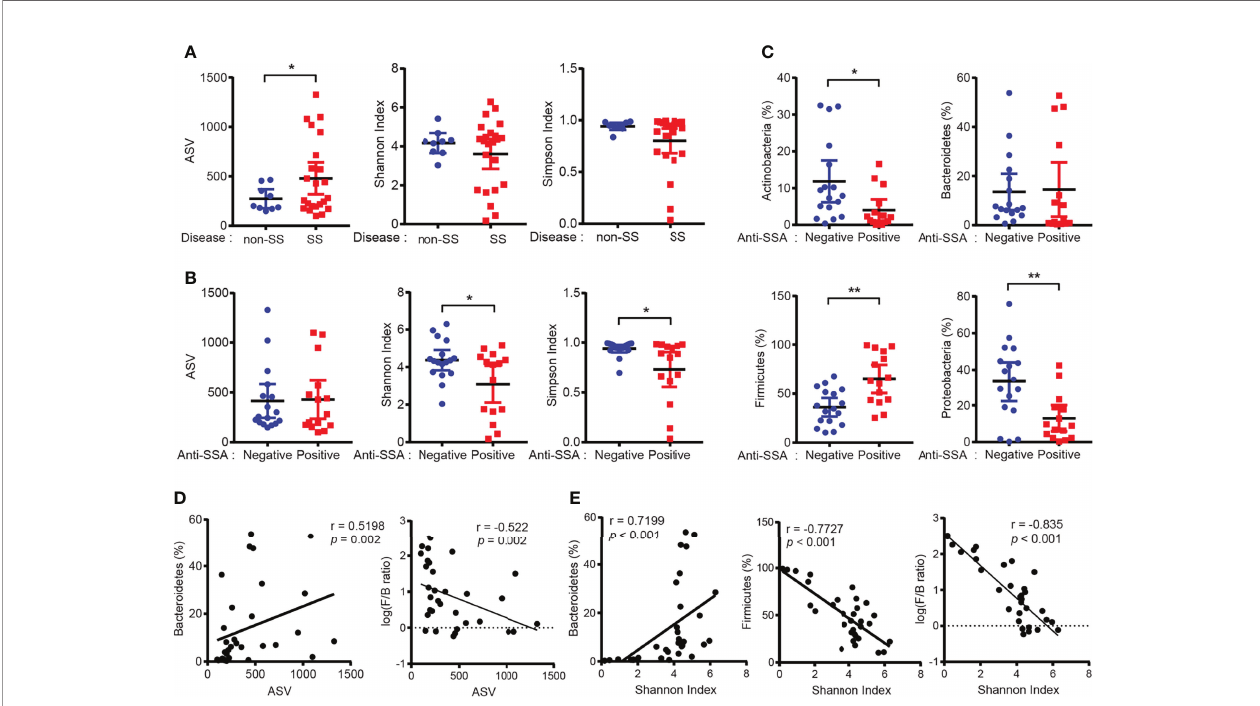
FIGURE 2 | Dysbiosis of salivary gland microbiome in patients with Sjögren ’ s syndrome (SS). (A) ASV (left), Shannon index (center), and Simpson index (right) of PG saliva microbiome in non-SS ( n = 9) and SS ( n = 23) subjects. (B) ASV (left), Shannon index (center), and Simpson index (right) of PG saliva microbiome in the anti- SSA-negative ( n = 17) and anti-SSA-positive ( n = 15) groups. (C) The abundance of the top four phyla in the PG saliva microbiome was compared between the anti- SSA-negative and anti-SSA-positive groups. (D) Correlation between ASV and abundance of Bacteroidetes (left) and log-scaled Firmicutes/Bacteroidetes ratio (F/B ratio, right) ( n = 32). (E) Correlation between Shannon index and proportion of Bacteroidetes (left) or Firmicutes (middle) and log-scaled F/B ratio (right) ( n = 32). Data are represented as mean ± 95% con fi dence interval. * p < 0.05, ** p <